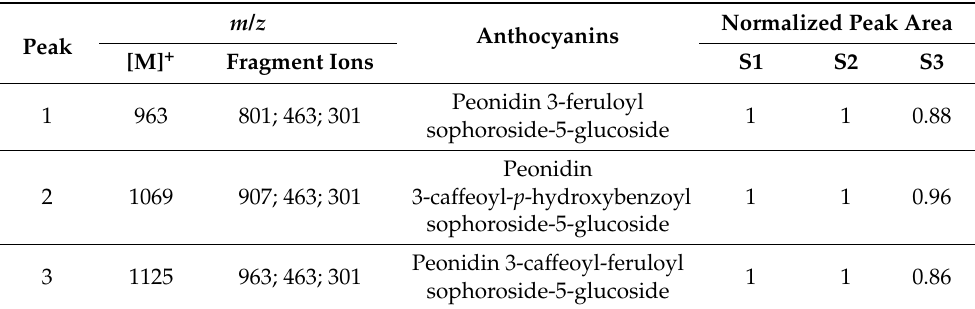
Figure 5. HPLC profiles of anthocyanins in ( a ) purple sweet potato (PSP) raw extract; ( b ) supernatant via centrifugation of raw extract at 4000 rpm for 7.8 min; and ( c ) permeate of supernatant via centrifugation and ultrafiltration (UF) (600 rpm, 30 kDa membrane, trans-membrane pressure (TMP) = 0.3 MPa). Table 2. Anthocyanin identification of purple sweet potato (PSP) extracts and samples obtained via the centrifugation and filtration